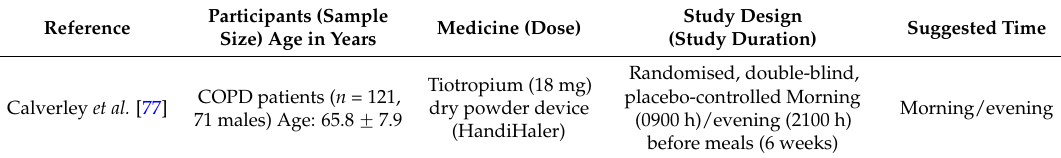
Table 5. Evidence supporting the chronotherapy for selected